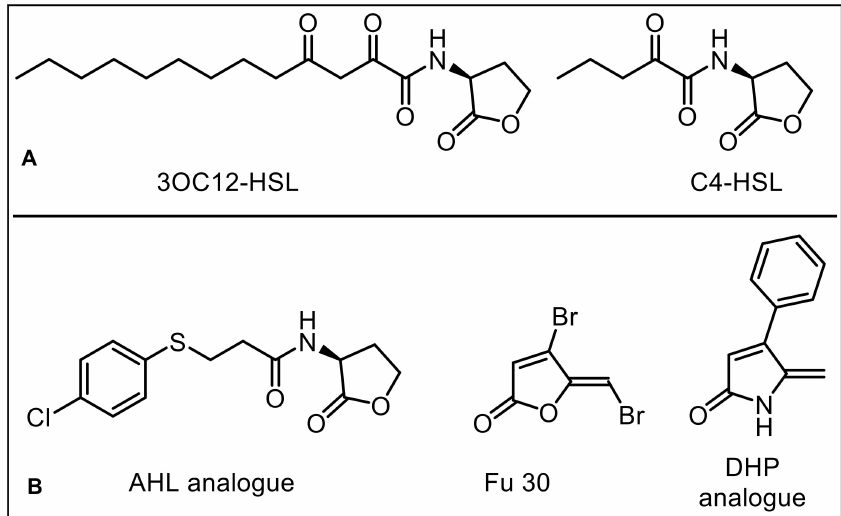
Figure 1. ( A ) AHL-based natural autoinducers of P. aeruginosa . ( B ) Synthetic AHL-based quorum- sensing inhibitors